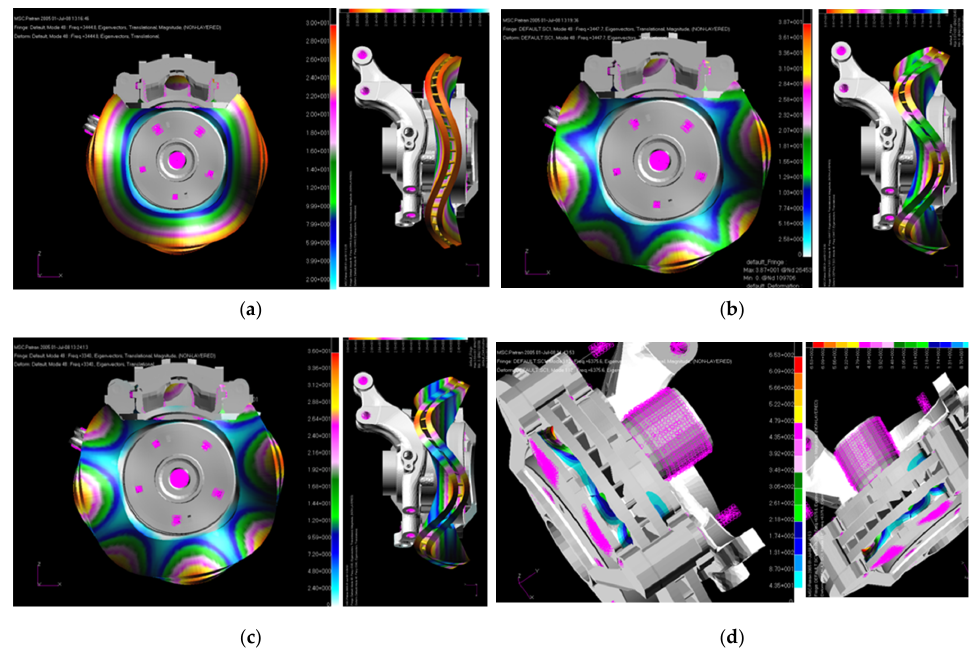
Figure 4. Configuration of mode shape of the assembled brake system model for different brake pressures: ( a ) 10 bar, ( b ) 20 bar, ( c ) 30 bar, and ( d ) 40